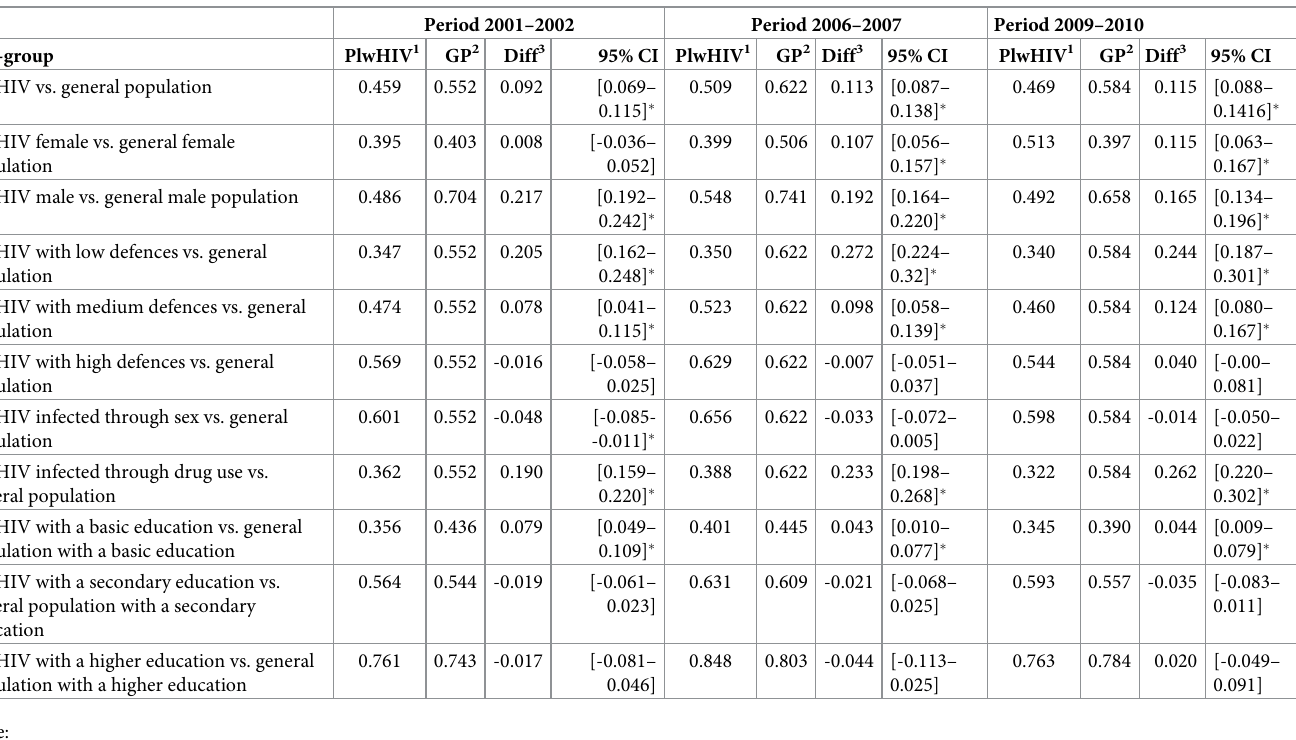
Table 2. Comparison of labour participation between PlwHIV and general population without controlling for socio-demographic